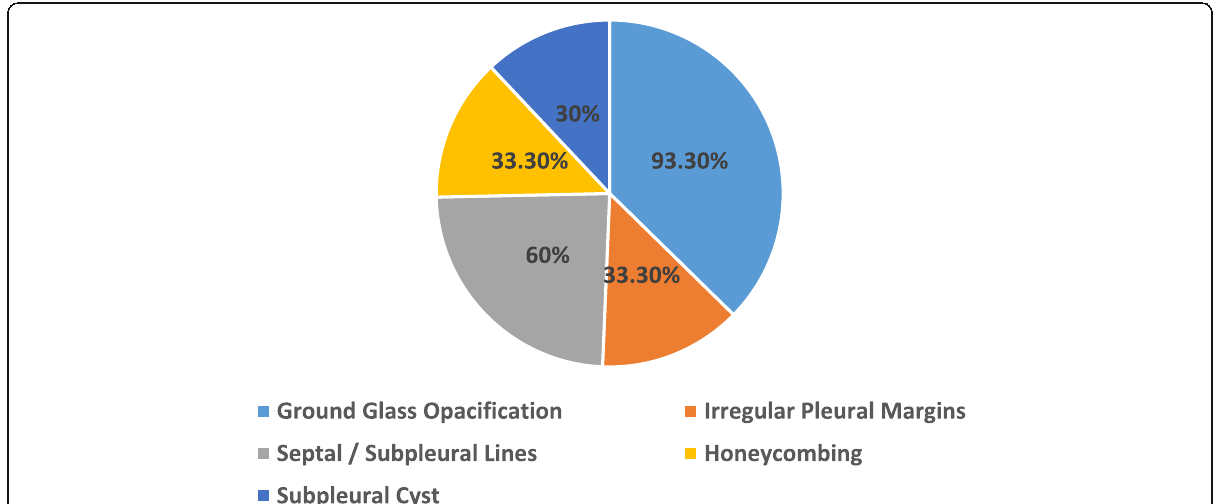
Fig. 5 Chart demonstrating the percentage of the semi-quantitative scoring system related fibrotic abnormalities among the systemic sclerosis cases in the